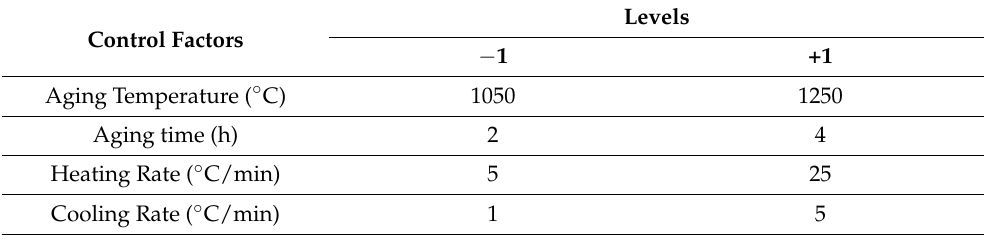
Table 8. Control factors and levels for vacuum sintering (RSM).